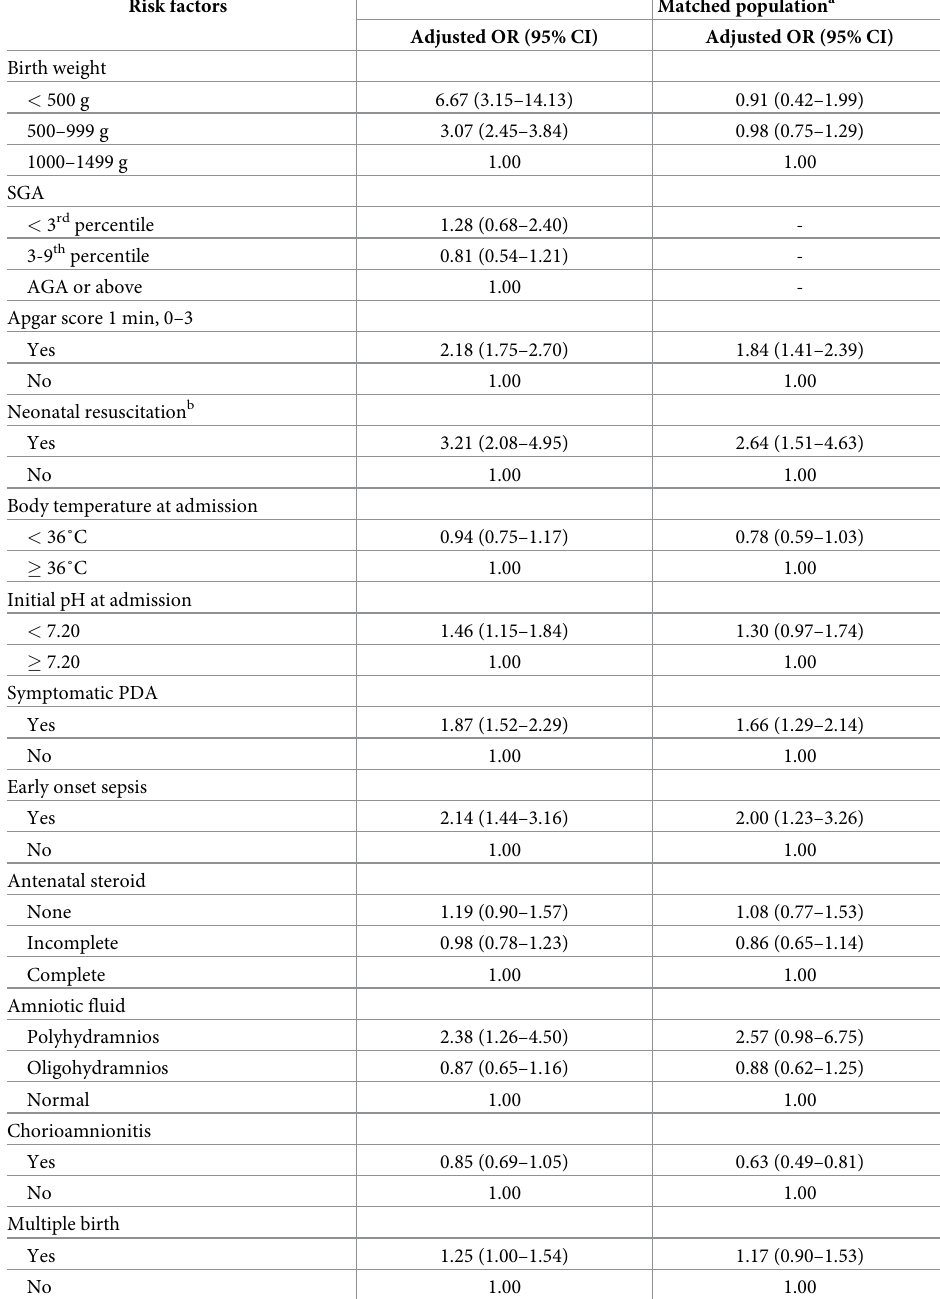
Table 3. Multivariate logistic regression model for risk